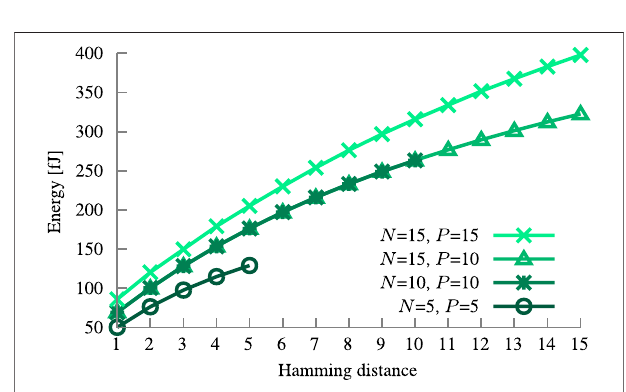
FIGURE 14 | Energy consumption of the Fe-TCAM block with synaptic comparator at given circuit con fi guration. Analysis is done at respective block size ( N ) and precision ( P